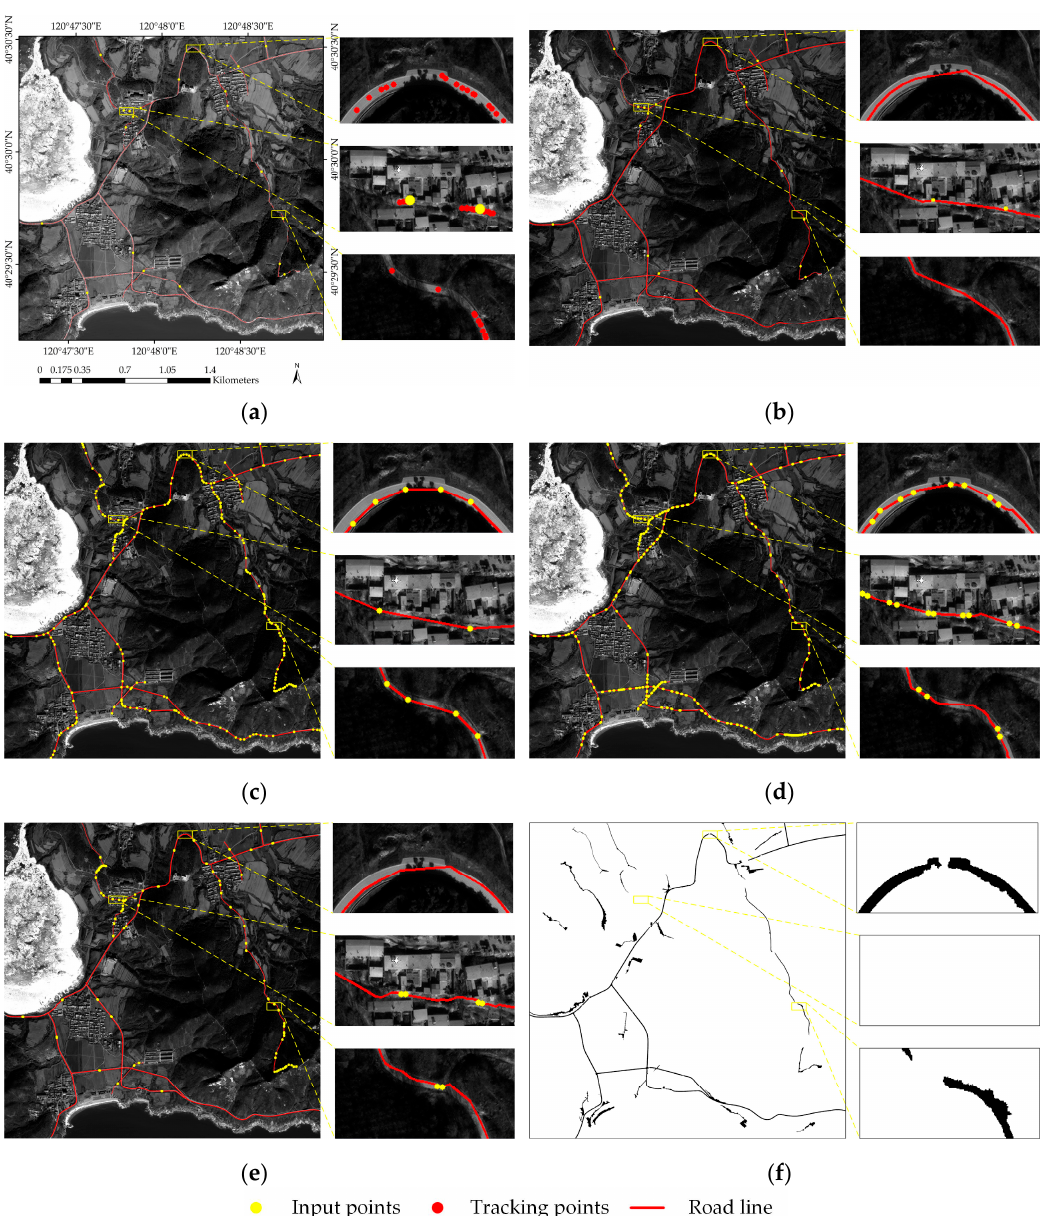
Figure 13. First study area: ( a ) Tracking point result diagram; ( b ) road extraction result of proposed method; ( c ) road extraction result of the ERDAS method; ( d ) road extraction result of the T-shaped template-matching method; ( e ) road extraction result of the rectangle method; ( f ) road extraction result of the eCognition method.